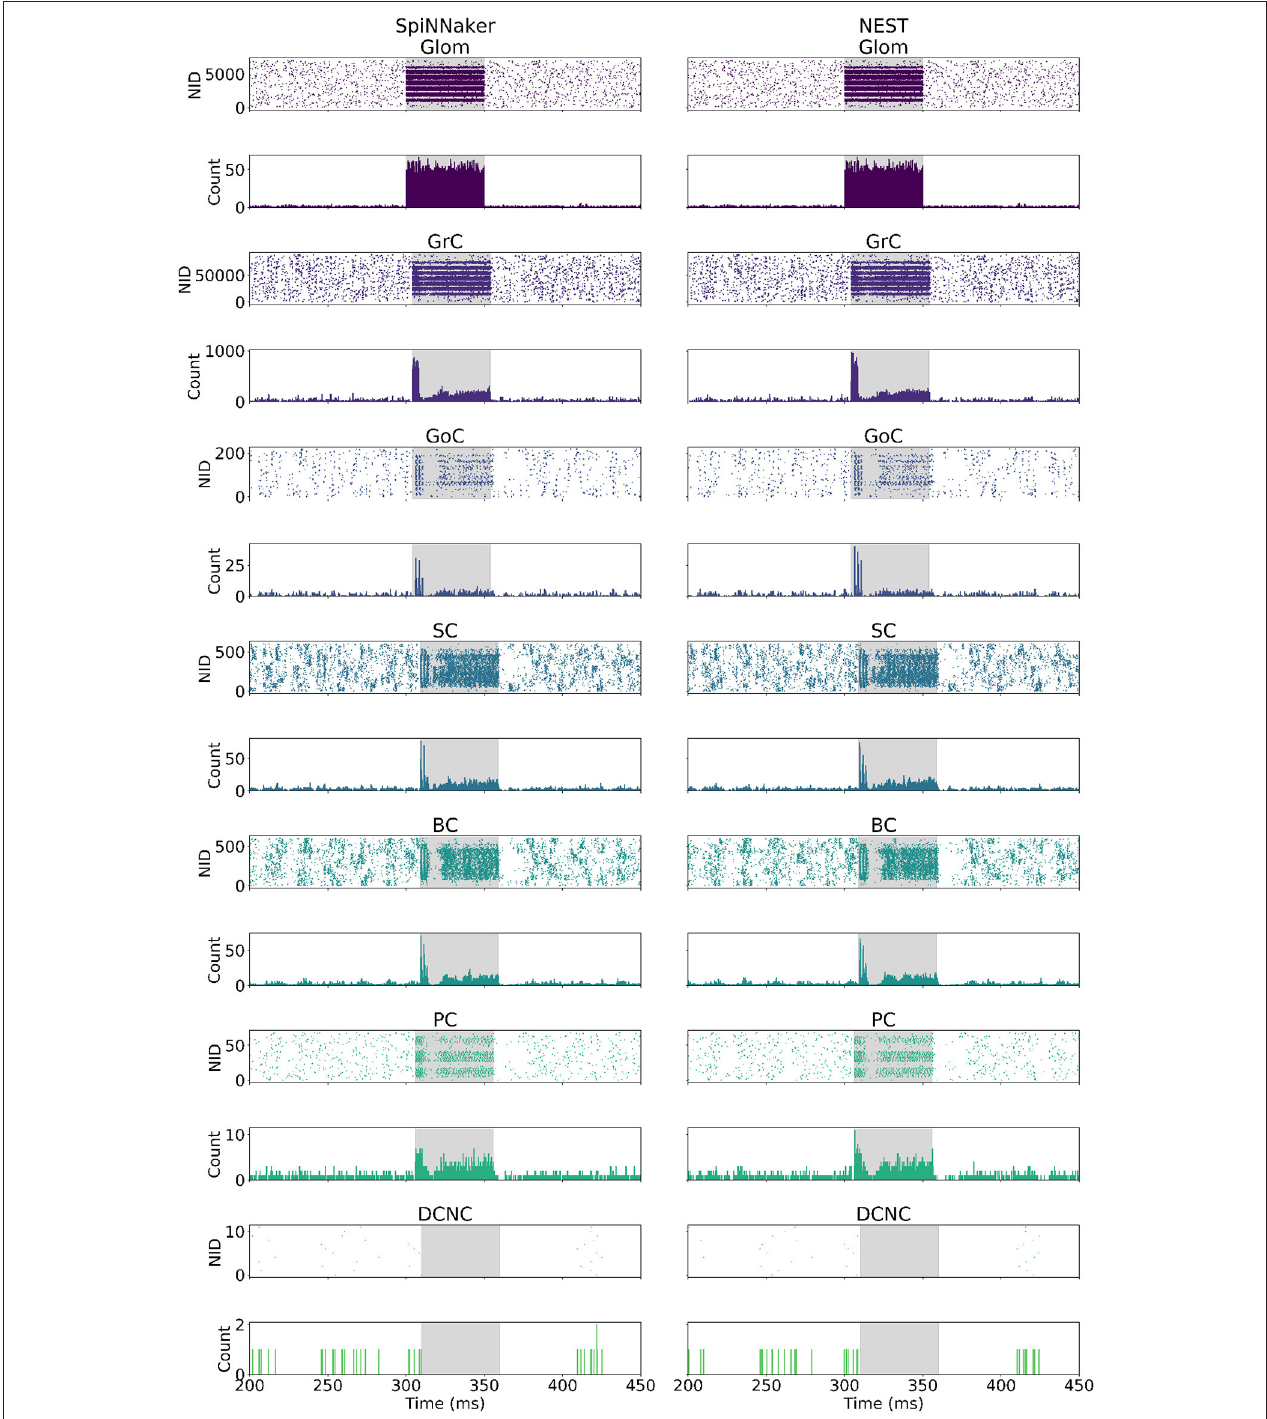
FIGURE 4 | Spike raster and peristimulus time histogram (PSTH) comparison. (Left) SpiNNaker. (Right) NEST. The bin width used for the PSTH is 0.1 ms. The highlighted area corresponds to the stimulation period for each cell type. NID, neuron ID.